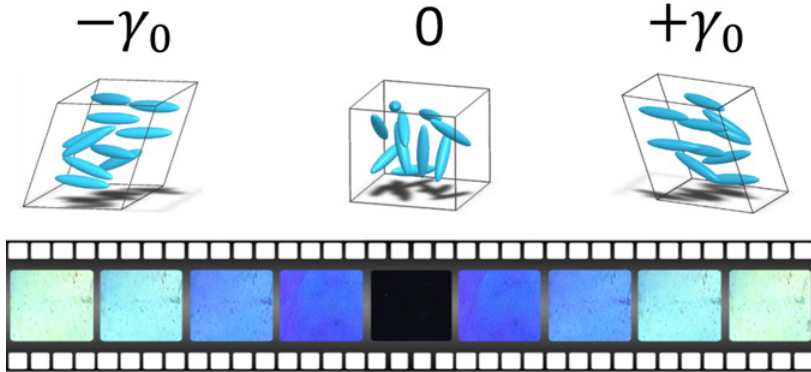
Fig 1. A low frequency mechanical excitation is applied to the isotropic phase of a liquid crystal. The photographs show that the liquid under stretching reversibly transits from a black to a bright state, revealing an unexpected elastic behavior. The snaphsots are recorded between crossed polarizers with a polychromatic light for one period of 0.5Hz and γ 0 = 10%. The isotropic phase appears black at rest; γ 0 =